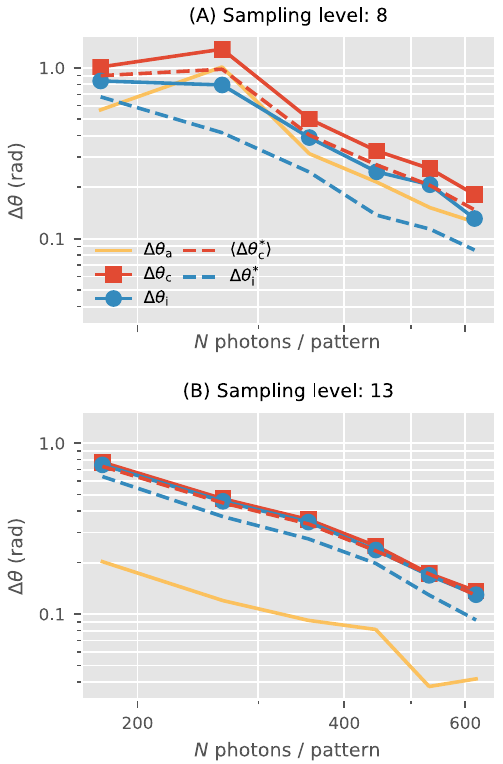
Figure 6. Effects of incident photon counts per pattern and sampling fineness of the latent orientation space. Each data point compares two 3D intensity reconstructions with 5000 photon patterns (solid lines), or each one of them with a ground truth 3D intensity volume (dashed lines). The rotation group is sampled with refinement levels n = 8 or n = 13 . As the average photon counts per pattern increases, all varieties of angular uncertainties specified in “Measures of orientation uncertainties” section decrease. The uncertainties involving the ground truth ( ∗ -superscript, dashed lines here) are typically lower than those with only the reconstructed volumes (solid lines). Finer orientation sampling reduces all orientation uncertainties. Furthermore, orientation disconcurrence ( �θ c , red) is dominated by inconsistency ( �θ i , blue) as orientation disagreement ( �θ a , yellow) is